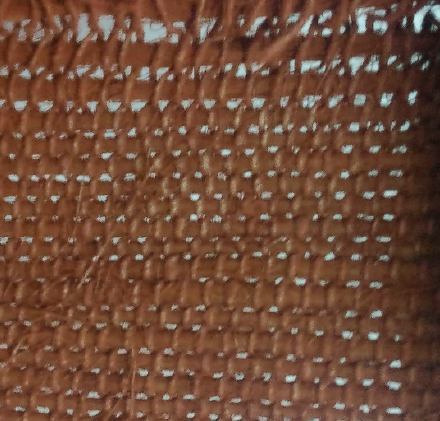
Figure 8. Iron oxide-coated sisal fiber-based filter media.